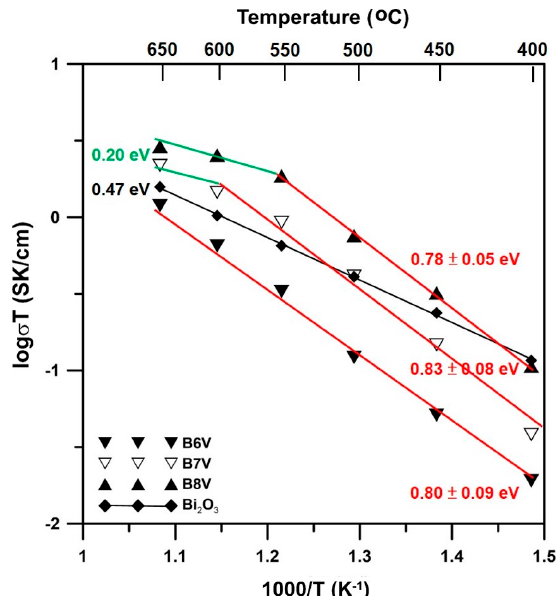
Figure 8. Electrical conductivities and activation energies of B6V, B7V and B8V samples measured by the two-probe direct current (DC) method in air.